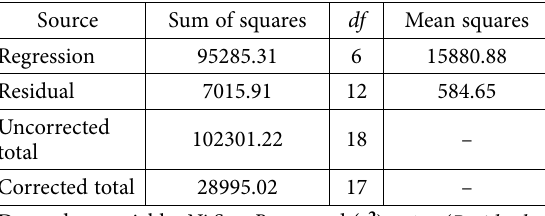
Table 5. ANOVA test for ‘non-linear model’